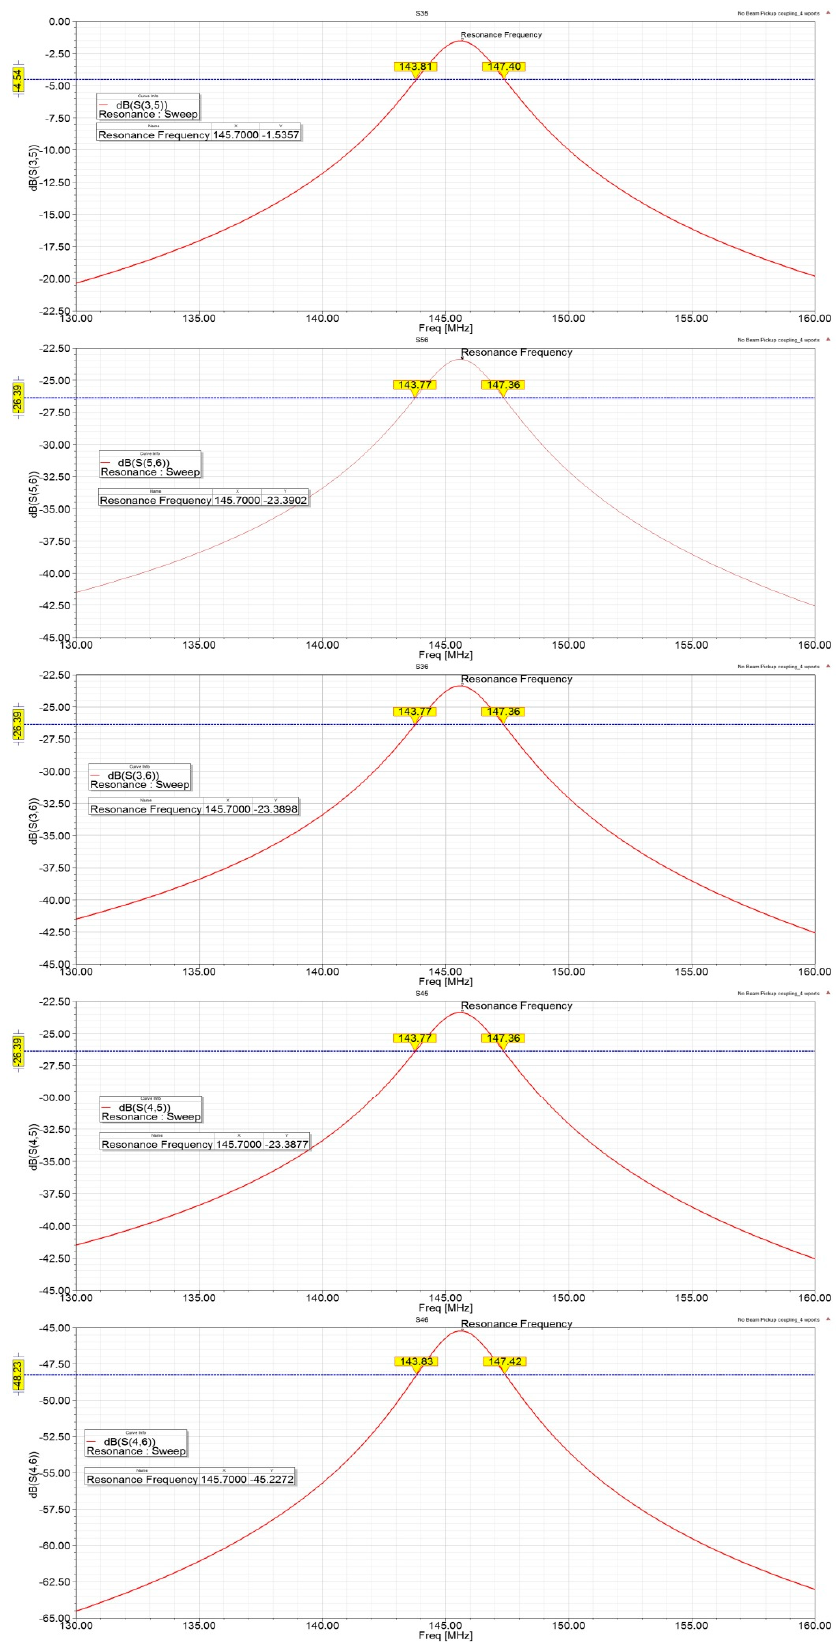
Figure A4. Pickup coupling S-parameters for all combinations of pickups.